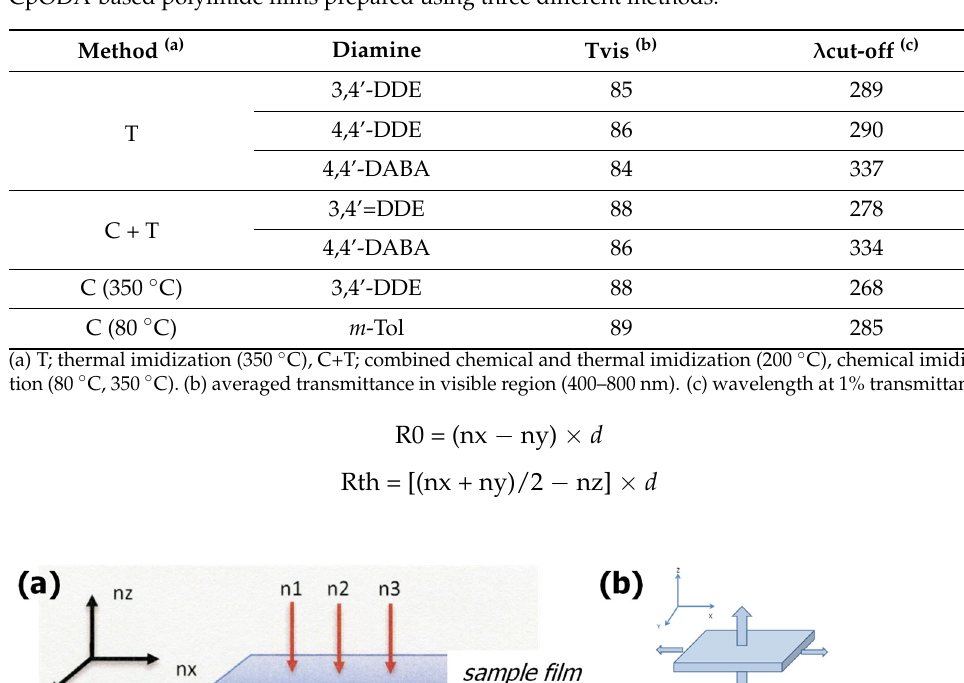
Table 3. The transparency in the visible region (Tvis) and the cut-off wavelength ( λ cut-off) of the CpODA-based polyimide films prepared using three different methods.